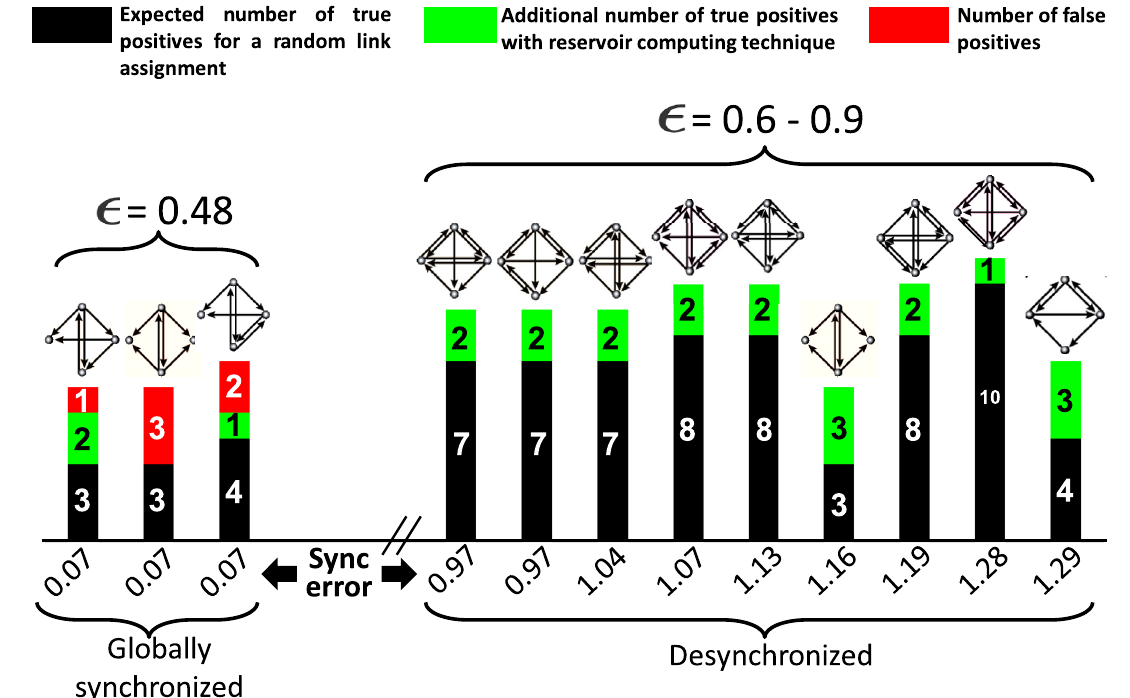
FIG. 9. Typical performance of our network inference method on experimental data. Each of the vertical bars corresponds to the experimental realization of a distinct optoelectronic oscillator network, with the height indicating the corresponding number of links. Each bar is separated into three segments as shown, but in many of them only two are seen if there is a perfect link inference. The numbers inside the segments indicate the corresponding heights of the segments, rounded to the nearest integers. Ranges of coupling strength ( ϵ ) and synchronization error for all the examples are indicated as